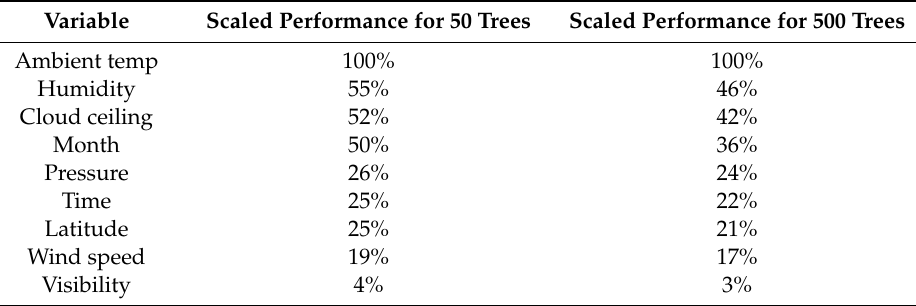
Table 5. Variable importance rankings using